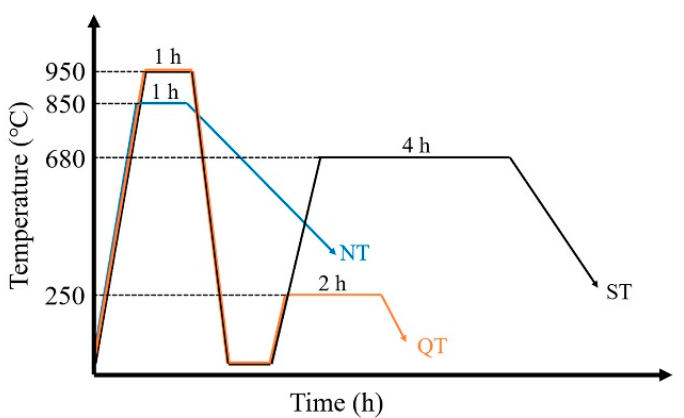
Figure 1. Schematic drawing of heat treatments for AISI 1045 steel. QT stands for quenching and tempering treatment, NT stands for normalizing treatment, and ST stands for spheroidizing treat- ment.